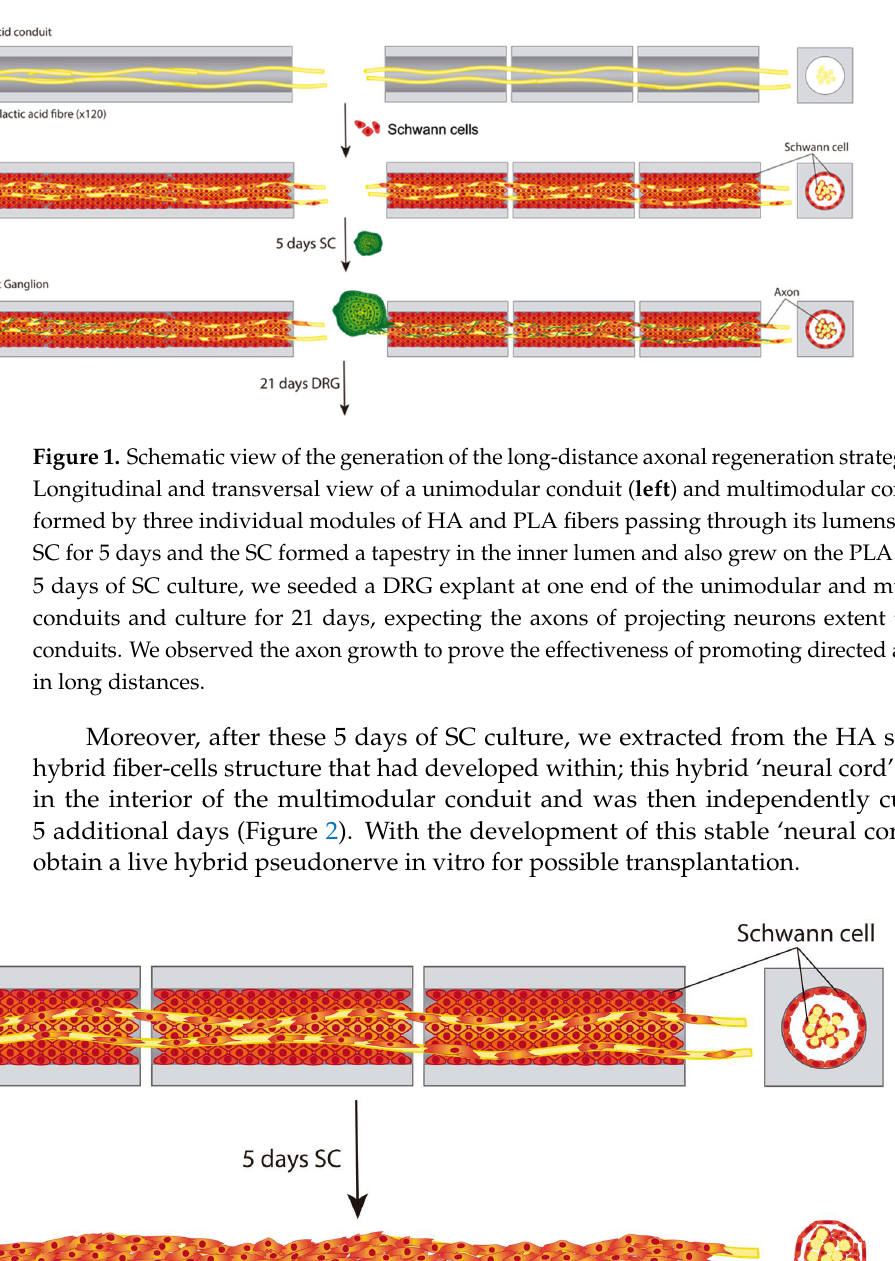
Figure 2. Schematic view of the generation of the ‘neural cord’. Longitudinal and transversal sche ‐ matic view of ‘neural cord’ after 5 days of SC culture and elimination of the HA conduits, obtaining a live hybrid pseudonerve in vitro for a possible transplantation.